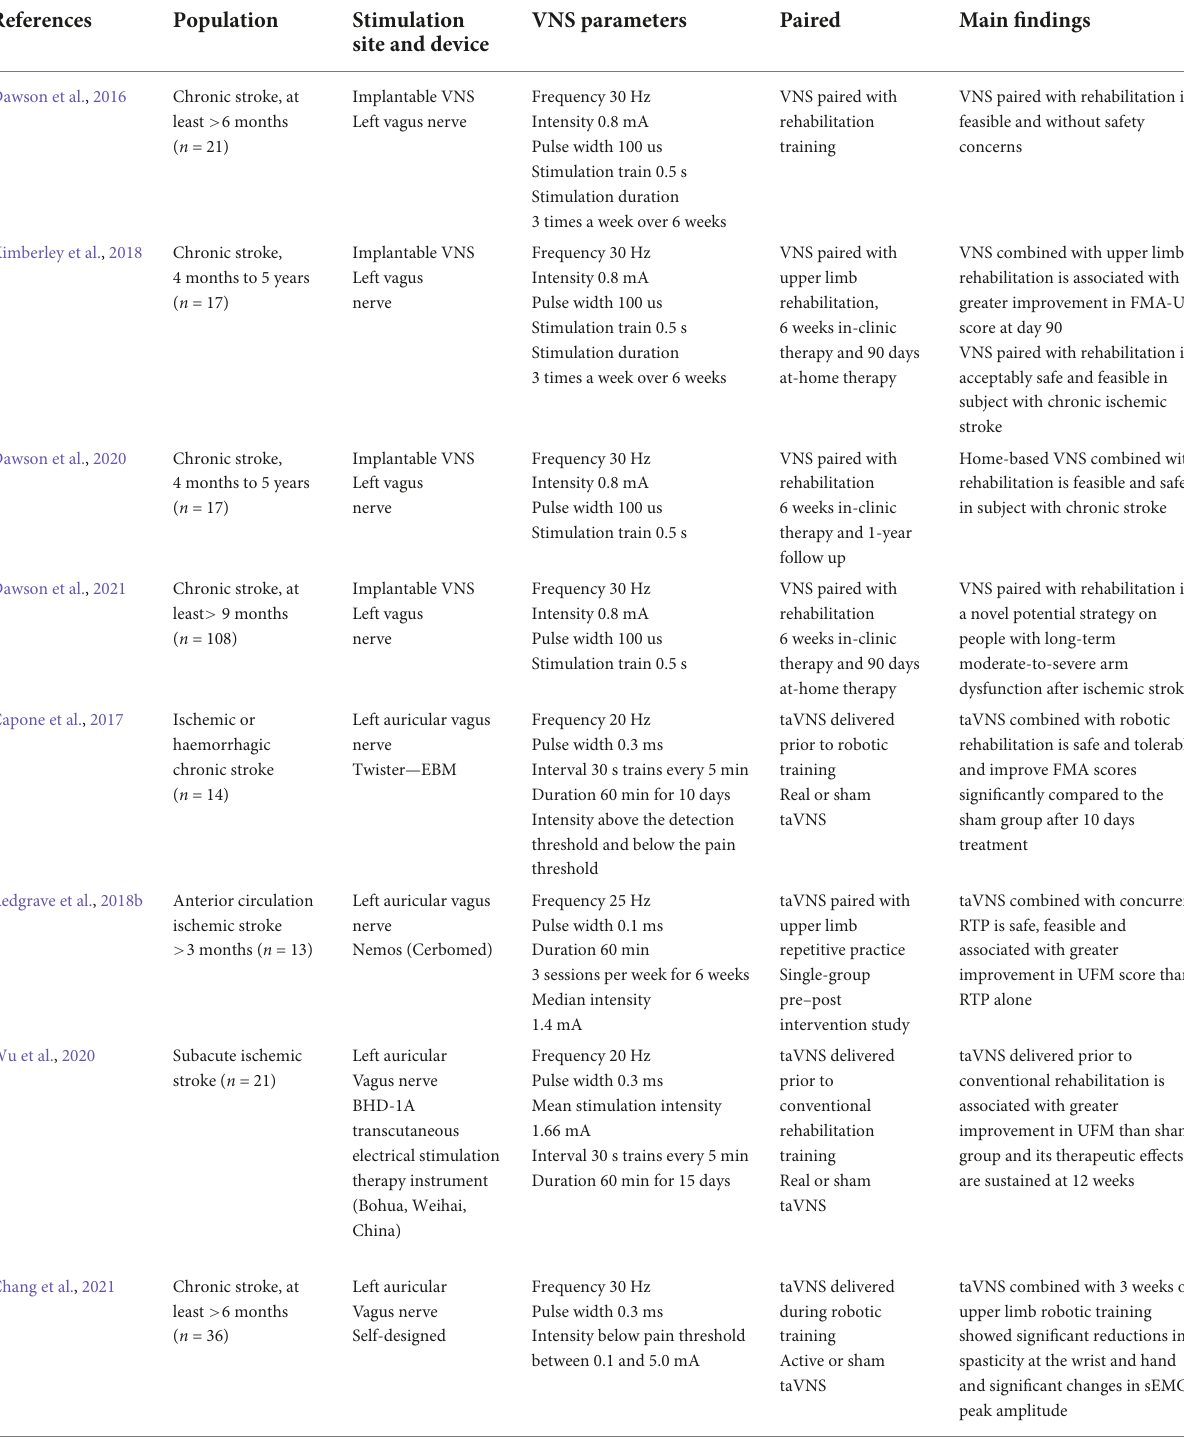
TABLE 2 Clinical studies of VNS in post-stroke upper limb